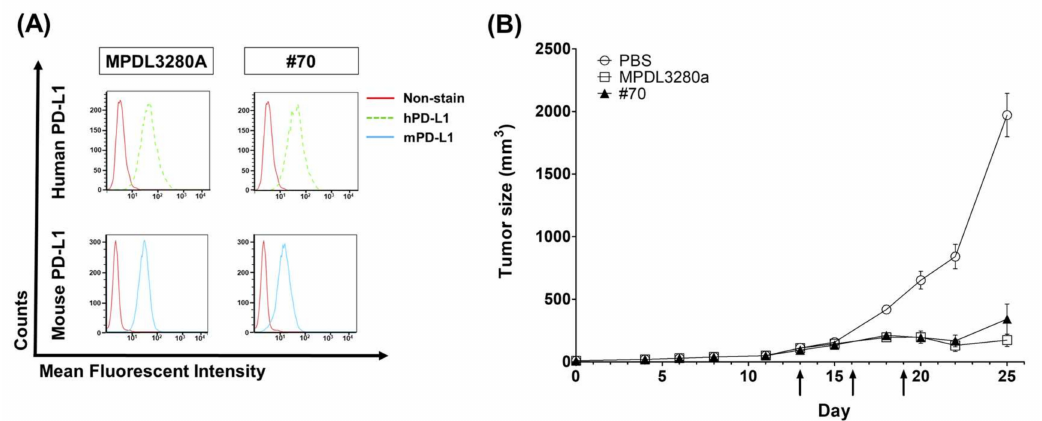
Figure 6. In vivo function of anti-PD-L1 antibody in MC38 syngeneic mouse model. ( A ) Flow cytometry analysis demonstrates cross-reactive binding of IgG-converted anti-human PD-L1 antibodies to human PD-L1 in PC3 cells, and mouse PD-L1 in mouse IFN- γ -treated MC38 tumor cells (100 ng / mL for 24 h); ( B ) Tumor growth curves of C57BL / 6 mice subcutaneously injected with MC38 tumor cells. Mice (C57BL / 6 bearing MC38 tumors, n = 5 per group, mean ± SD) were treated with PBS or mouse PD-L1 cross-reactive antibodies (MPDL3280A and #70). Treatment was given by intraperitoneal injection (10 mg / kg) on the days marked with black arrows. t -test; ***; p ≤ 0.001 by unpaired t -test on day